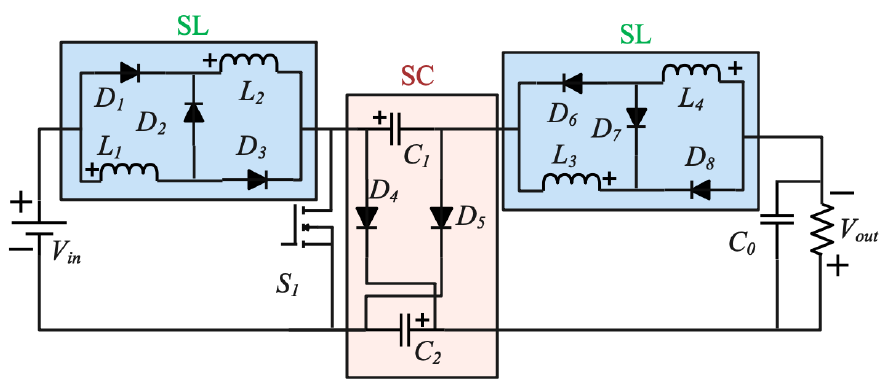
Figure 8. Topology 3: Power circuit of type-2 switched-inductor-switched-capacitor (SLSC) Cuk